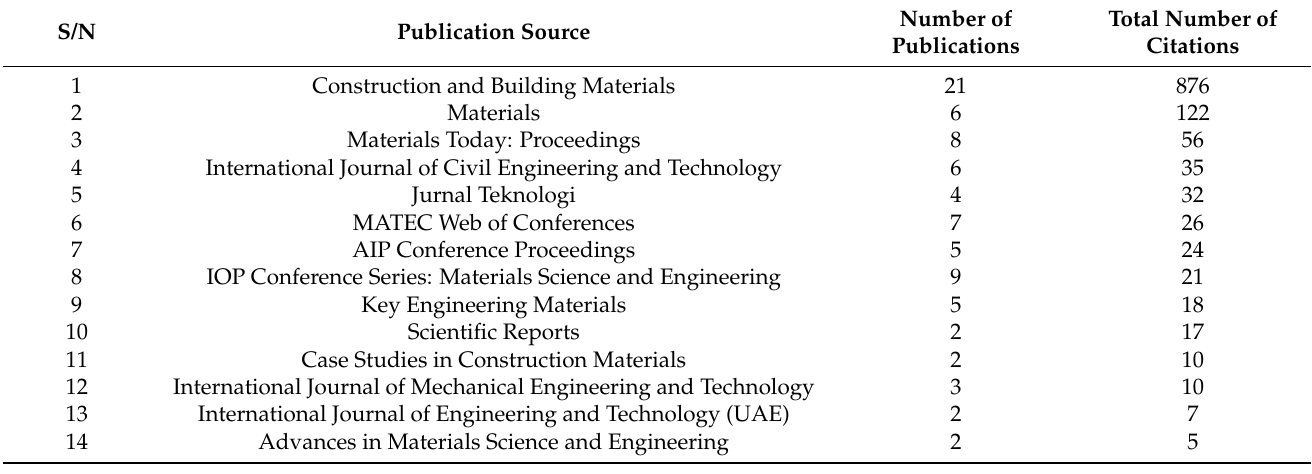
Table 1. Publication sources in the related research field up to 2022.